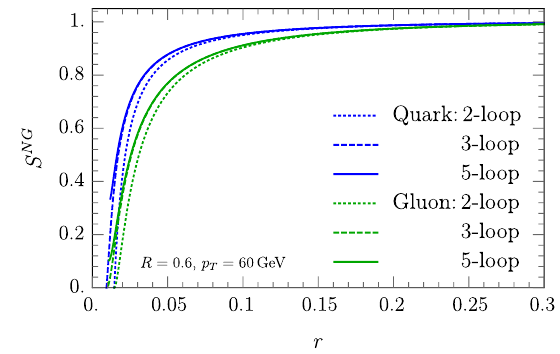
Figure 3 . The non-global contribution to the soft function in eq. (2.26) for quark jets (blue) and gluon jets (green) with R = 0 : 6 at p T = 60 GeV. Shown are the results up to two-loop (dotted), three-loop (dashed) and (cid:12)ve-loop order